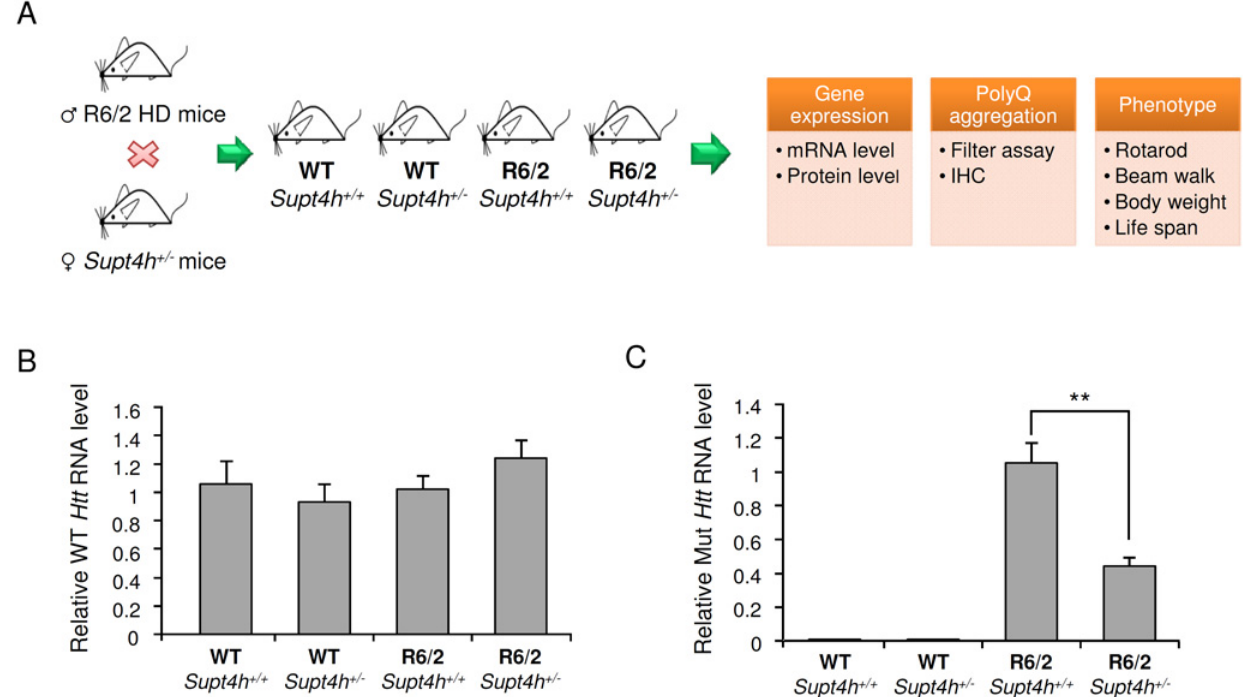
Fig 3. Effect of heterozygous deletion of Supt4h on expression of mutant and wild-type Htt alleles in R6/2 mice. (A) Outline of procedures used to generate heterozygous deletion of Supt4h in R6/2 HD mice by crossing with Supt4h +/- mice, followed by summary of biochemical and phenotypic analyses of their offspring. (B) Expression of wild-type murine Htt gene was assessed by qRT-PCR using U6 as an internal control. Samples were collected from left cerebrum of indicated animals at the age of 12 weeks, and the gene expression in WT mice containing two functional Supt4h alleles was set as 1. (C) Same as (B), except that expression of mutant Htt allele was analyzed and mutant Htt expression in R6/2 mice containing two functional Supt4h alleles was set as 1. Data are presented as the mean ± SEM (n = 3 in each group; ** , p < 0.01 by Student ’ s t -test).